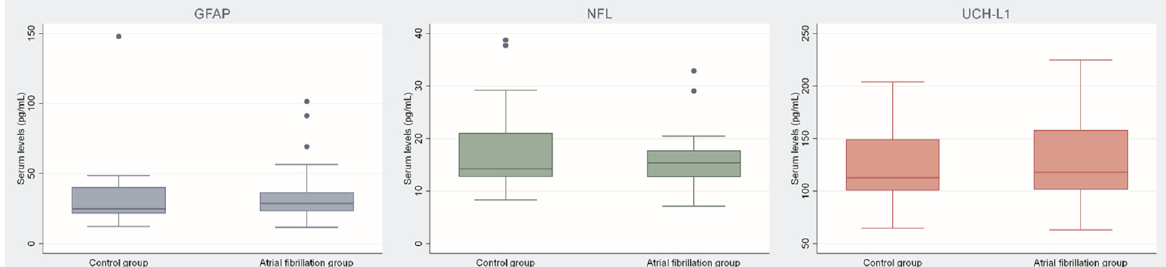
Figure 1. Comparison of biomarkers between the atrial fibrillation group and the control group. Legend: GFAP—glial fibrillary acidic protein; NFL—neurofilament light chain; UCH-L1—ubiquitin C-terminal hydrolase L1.